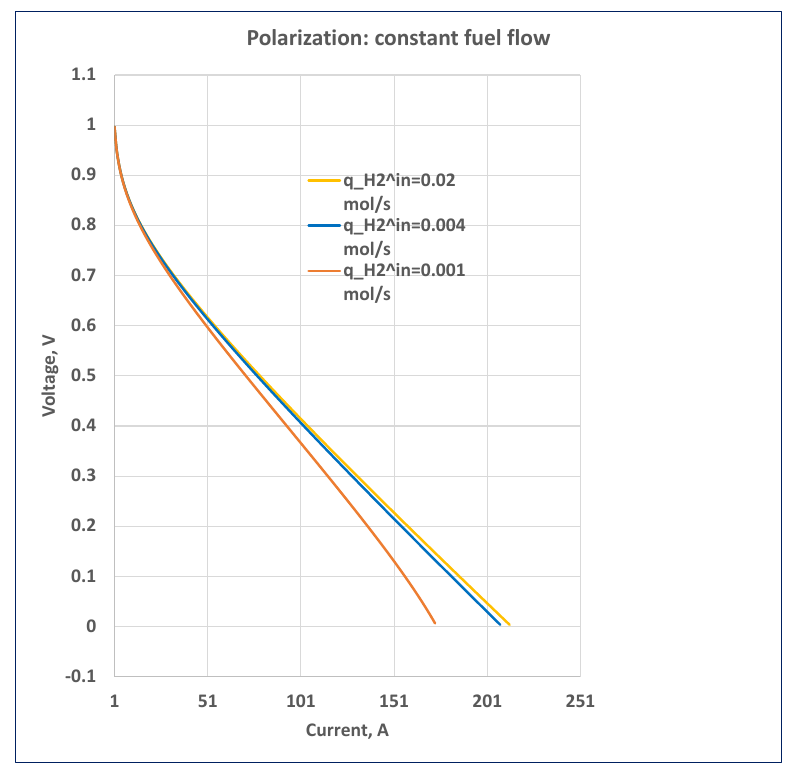
Figure 8. Effect of the input hydrogen flow rate on polarization (both input flow rates are held constant, with the oxygen flow rate proportional to the hydrogen flow